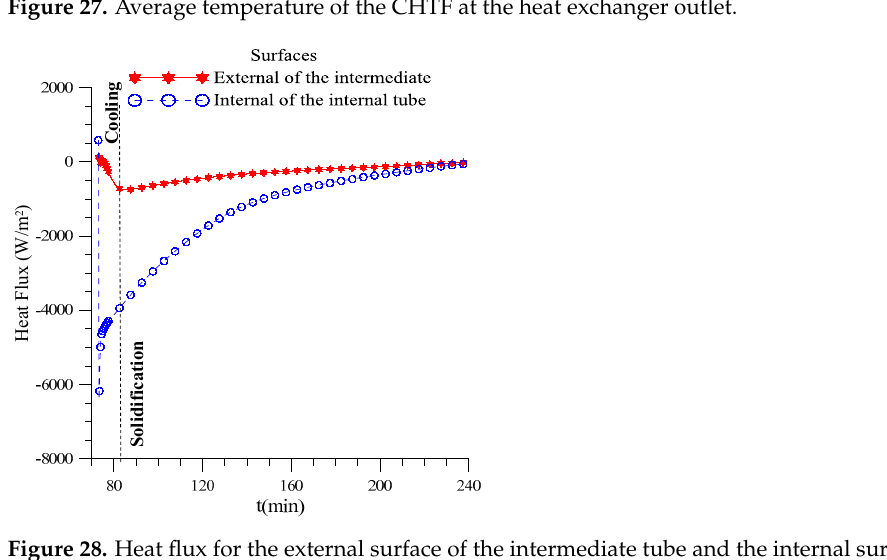
Figure 27. Average temperature of the CHTF at the heat exchanger outlet.